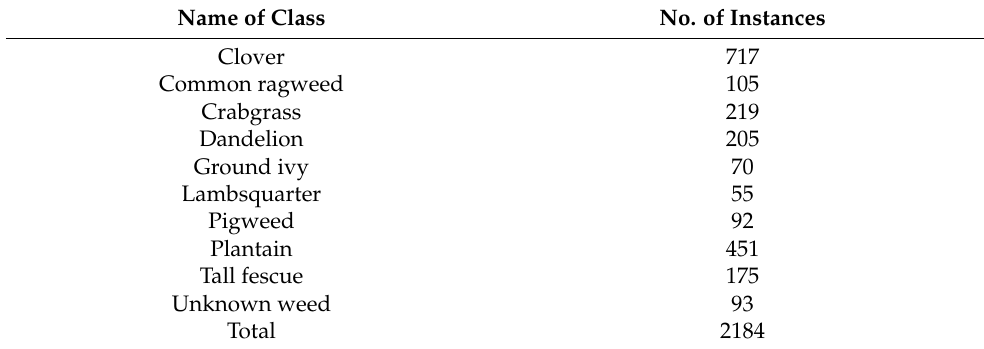
Figure 6. Examples of intra-class (crabgrass) variations. Table 1: The table shows the total number of weeds contained in the 1006 weed dataset. It can be inferred that the distribution of weed species is not